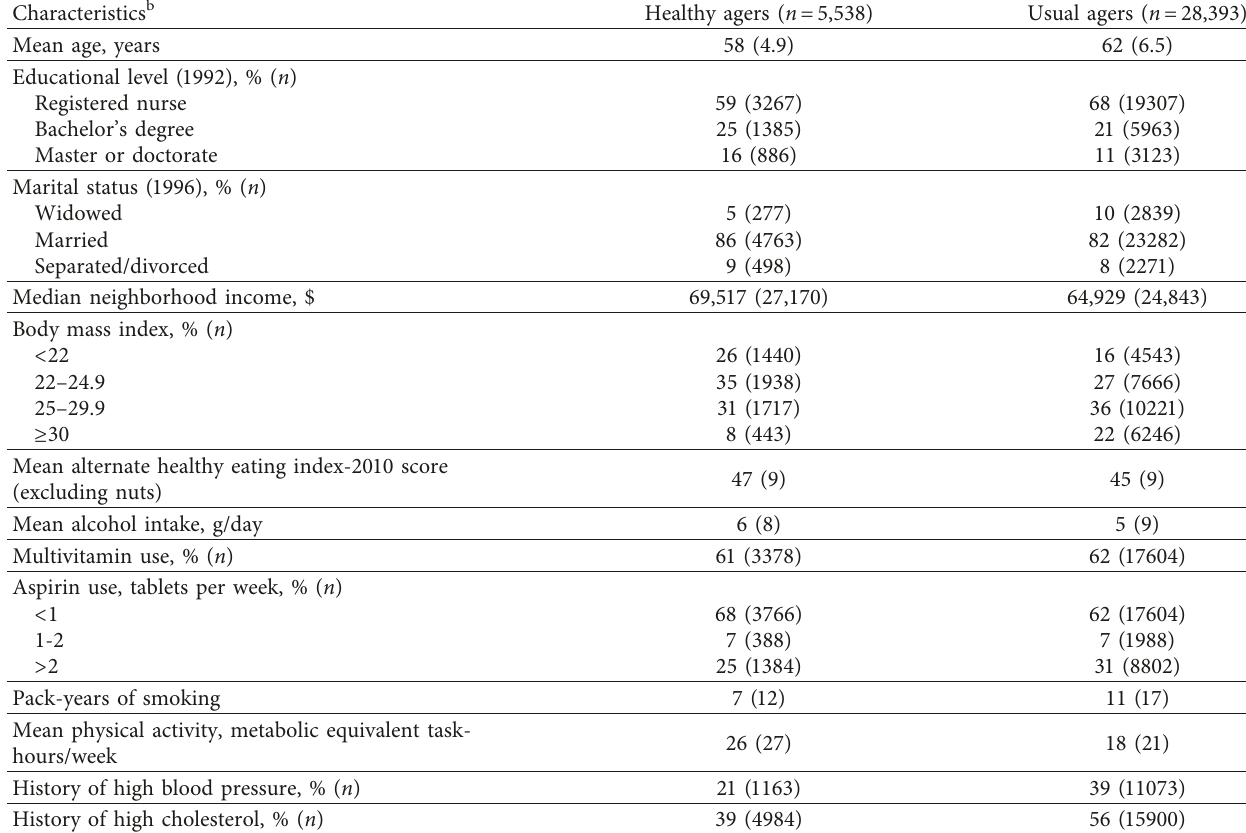
Table 1: Characteristics at study baseline a of usual agers and healthy agers in the Nurses’ Health Study.